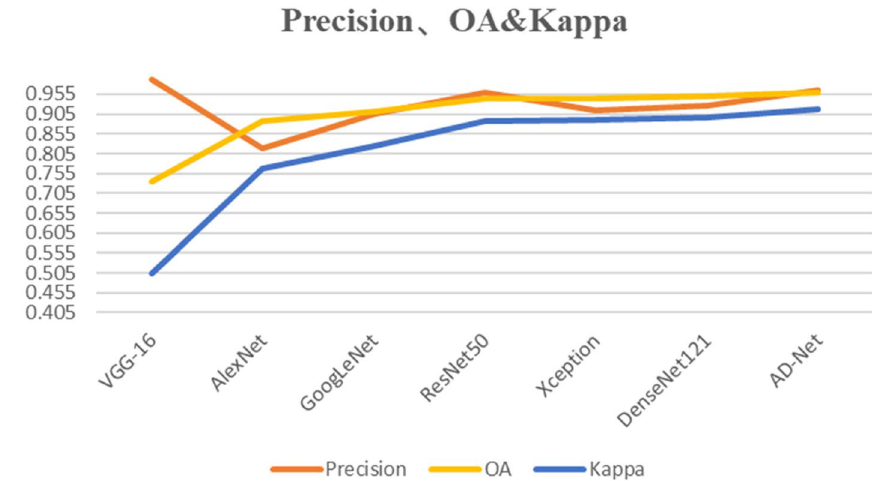
Fig. 8 Comparing the Precision, OA, and Kappa metrics of the models and the proposed model on dataset 3